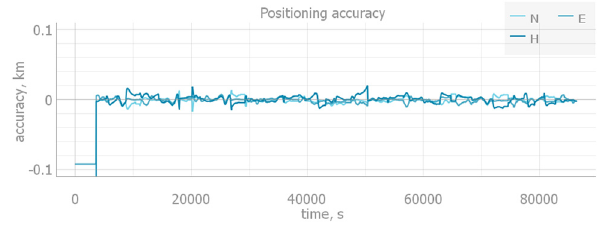
Figure 9: Static user positioning accuracy.